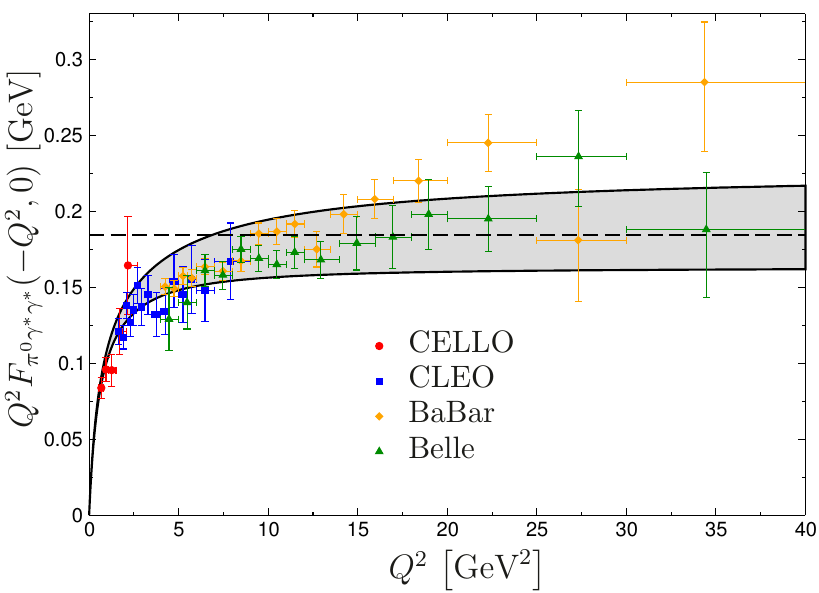
2 ; 0) as a function of Q 2 , in comparison to (cid:25) 0 (cid:13) (cid:3) (cid:13) (cid:3) ( (cid:0) Q